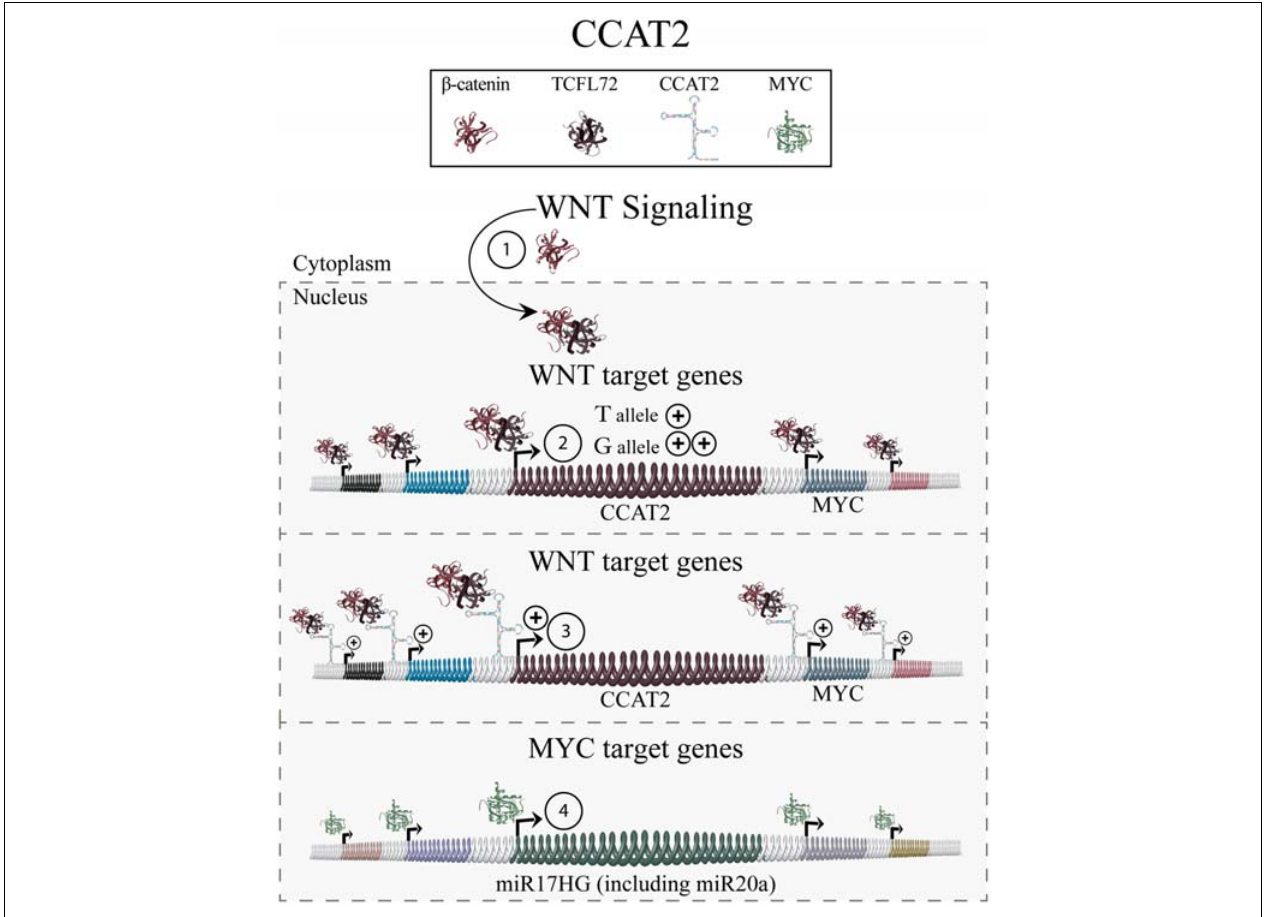
compared to theTT allele. CCAT2 then exhibits a positive-feedback reinforcing WNT signaling (3).The increased levels of MYC, in turn, leads to elevated levels of its downstream targets (4) including known metastasis mediators, such as miR17HG and miR20a, and promotes an increased metastatic